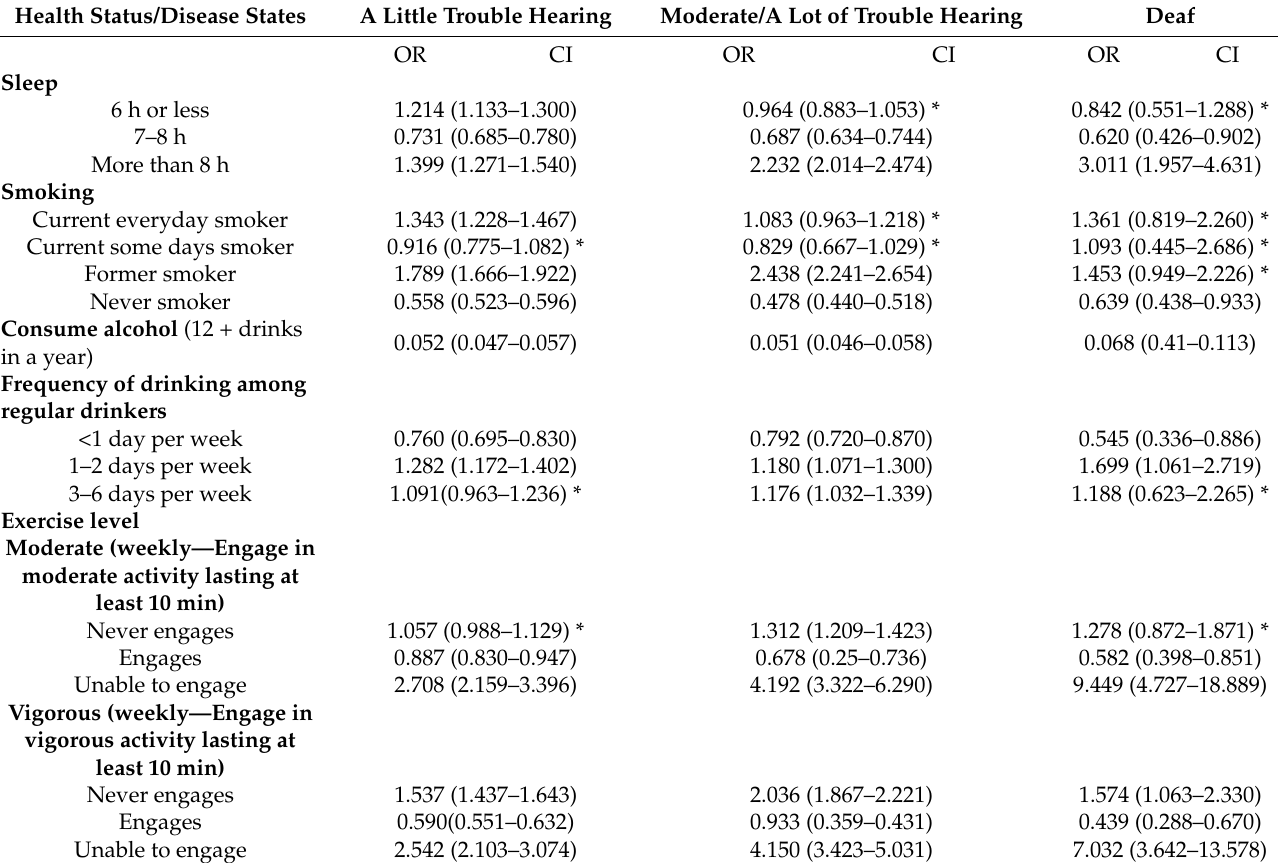
Table 7. Comparison of lifestyle/health behaviors by level of hearing loss compared to excellent/good hearing status. Health Status/Disease